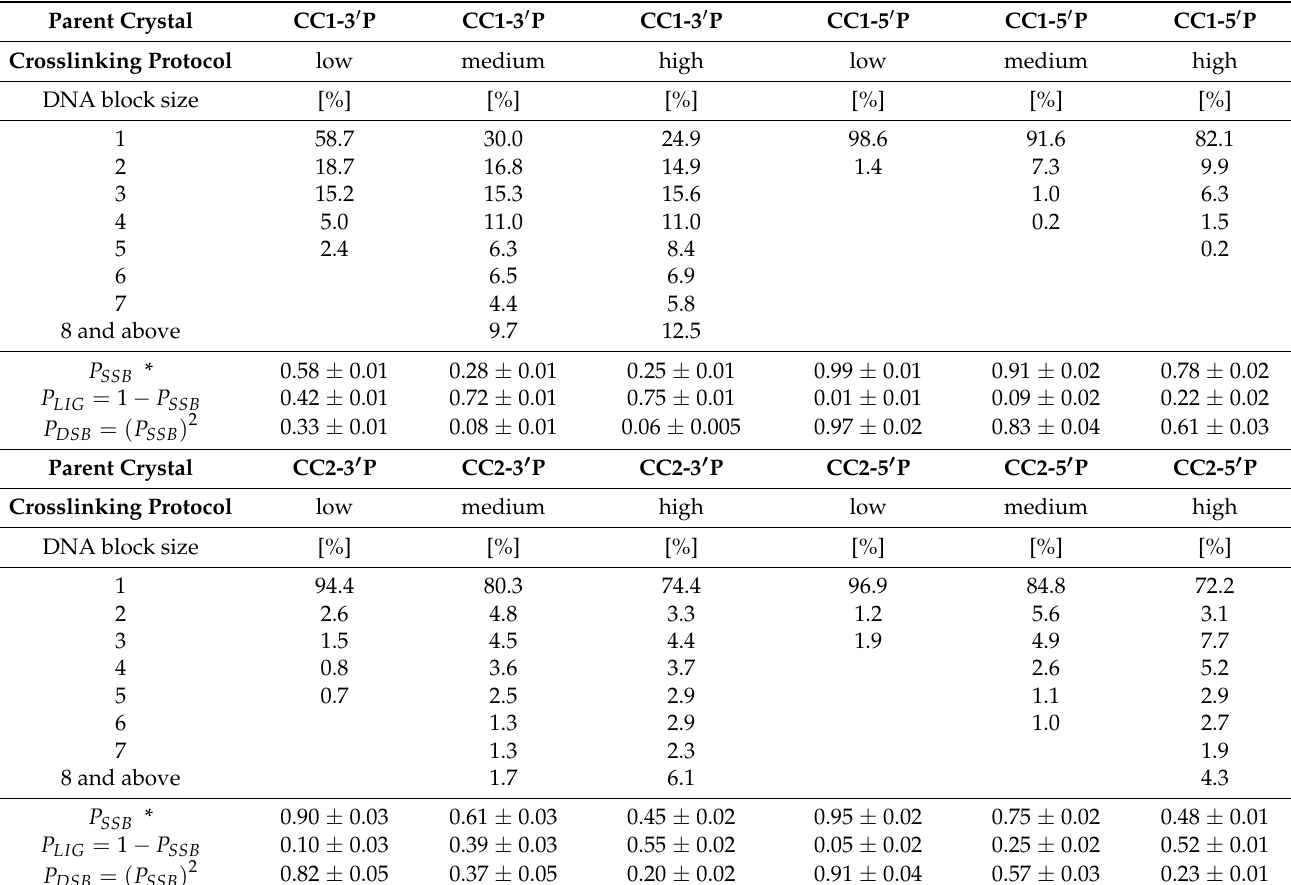
Table 4. Distribution of DNA block sizes as a function of crosslinking protocol and 3 (cid:48) vs. 5 (cid:48) terminal phosphates. The data shown correspond with the gel lanes in Figure 4. The crosslinking protocols low, medium, and high were 1 dose of 5 mg/mL EDC for 12 h, 1 dose of 30 mg/mL EDC for 12 h, and 2 doses of 30 mg/mL EDC for 12 h each, respectively. The values in this table are weighted so that the DNA length and dye intensity contributes to the final value. Unweighted values are found in Table S2. The full table, including estimated mole fractions for higher-order products, is found in Table S3. P SSB , P LIG , and P DSB were calculated for each crosslinked crystal sample. Uncertainties are standard deviations in derived quantities after 500 trials in which noise (standard deviation 0.03) is introduced into relative band